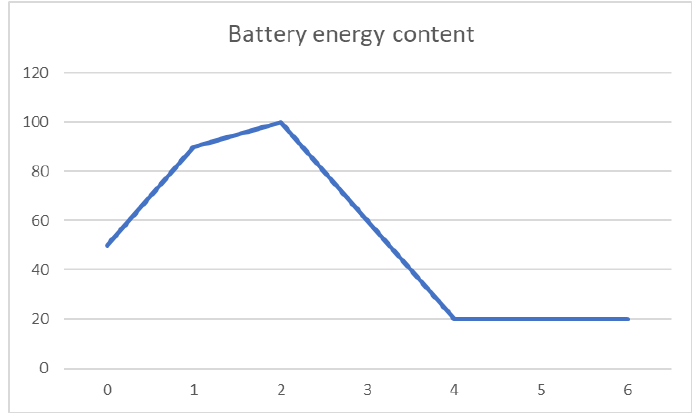
Figure 4. Illustration of baseline and energy content development.